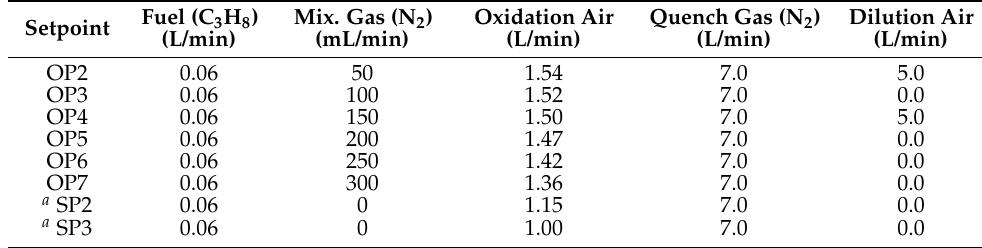
Table 1. The different miniCAST settings used. OP-numbered settings are sourced from the manu- facturer, while SP-numbered settings are sourced from Ess et al. [25]. Lower OP numbering relates to, according to previous studies, a higher level of soot maturity [26,27]. Settings OP2 and OP4 additionally used the internal dilution flow of the miniCAST in order to lower particle